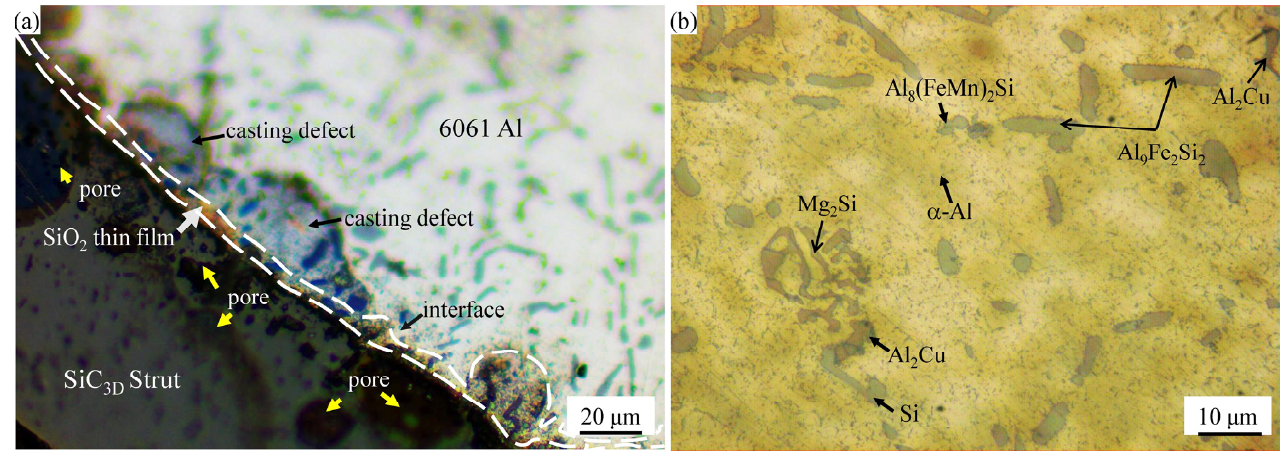
Figure 2. Optical micrograph (OM) image of two materials: ( a ) SiC 3D /6061Al; ( b ) 6061Al alloy.